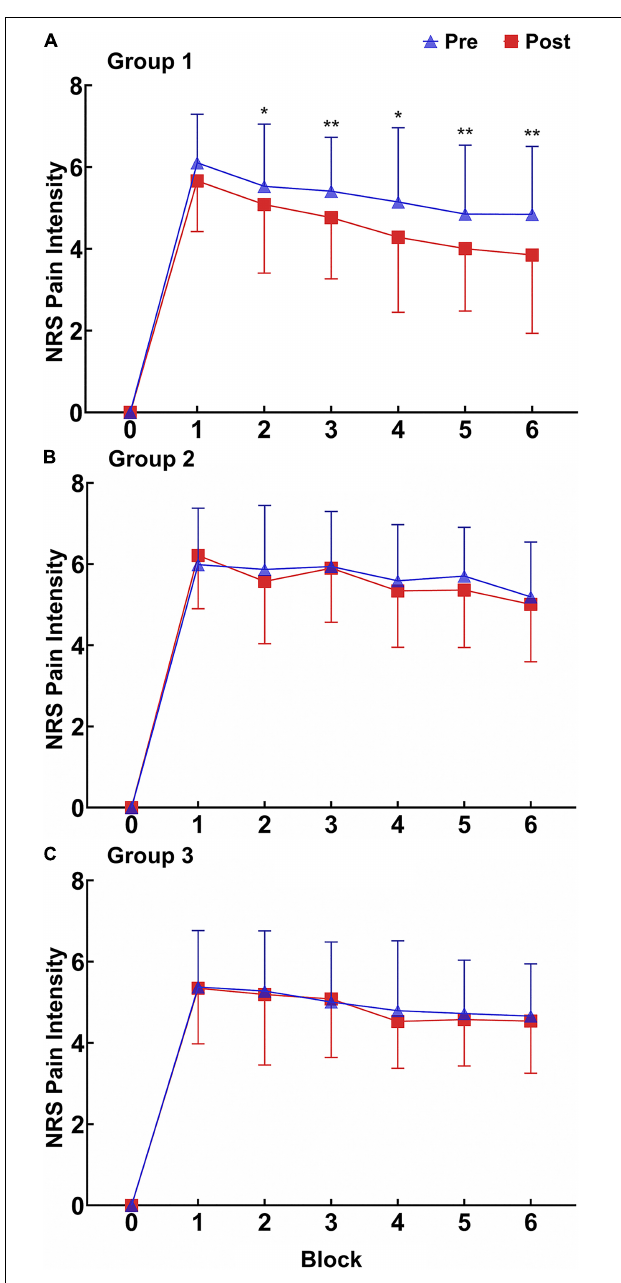
FIGURE 5 | Pain unpleasantness ratings (X ± SD) of RPHS before and after intervention in the three groups. (A) Group 1. (B) Group 2. (C) Group 3. NRS, numeric rating scales; Pre, pretest; Post, posttest. * p < 0.05; ** p < 0.01.